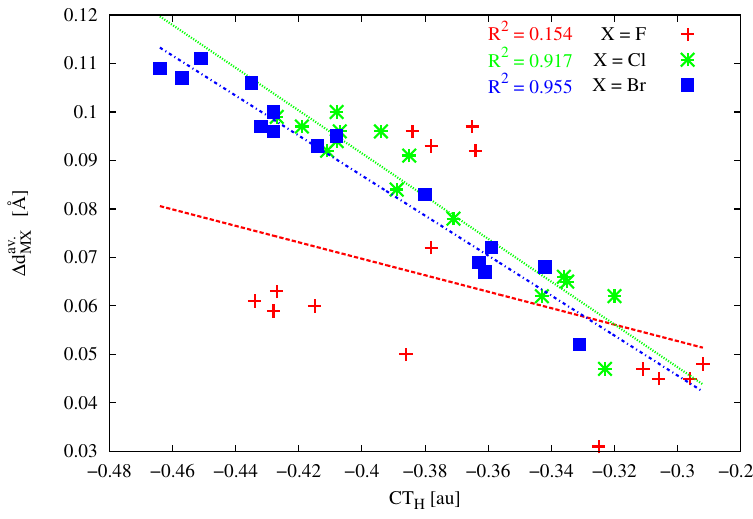
Figure 10. Relationship between charge transfer (CT H ) and the averaged elongation of the MX bond ( ∆ d av. ). MX